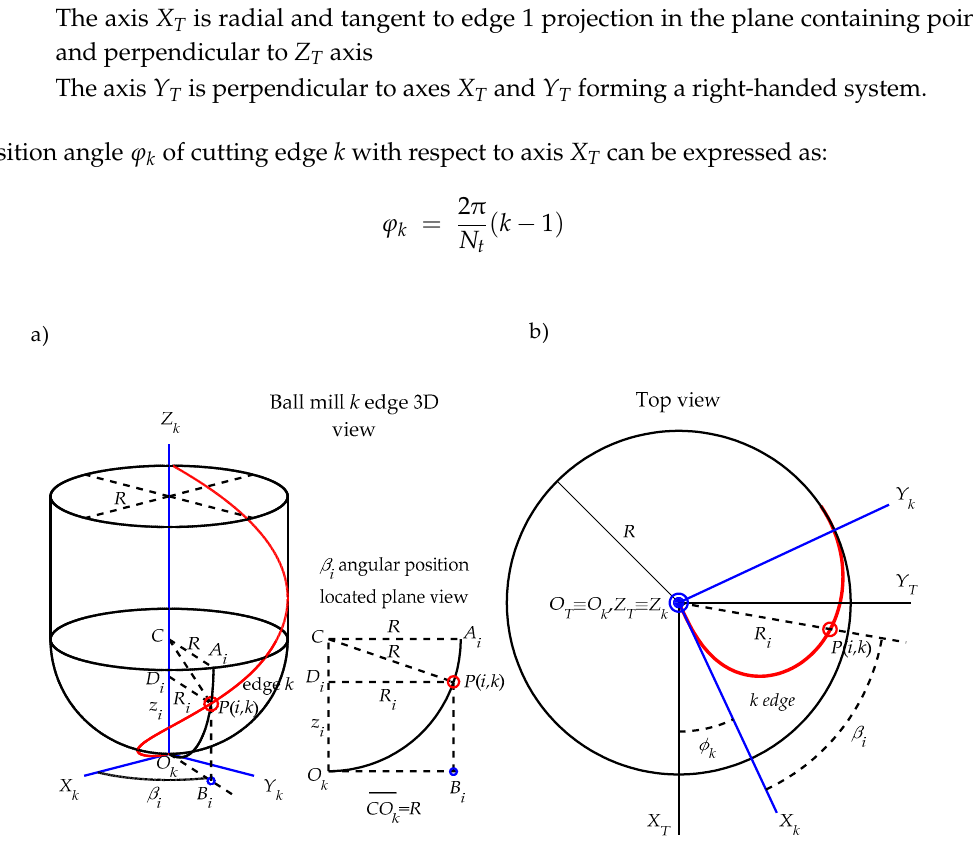
Figure 8. Ball end mill geometry ( a ) and k edge geometry definition ( b ).